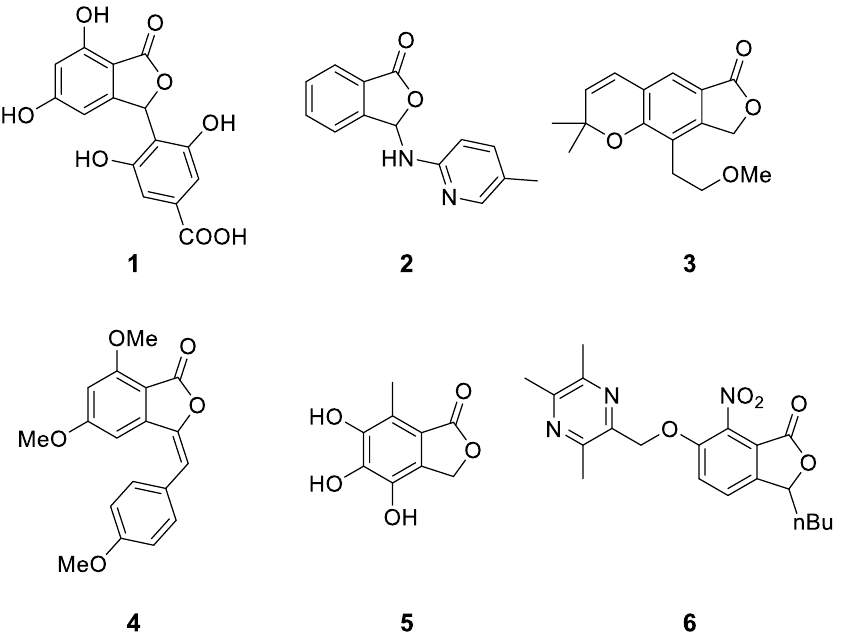
Figure 1. Some relevant examples of isobenzofuranones derivatives with demonstrated biological activities.